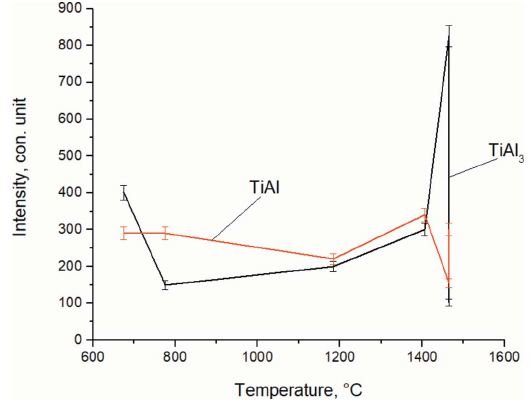
Figure 12 Change of TiAl (111) and TiAl 3 (112) in situ intensity of reflections from temperature during high-temperature synthesis at T = 674 (cid:3) C until the system reaches a thermal explosion.